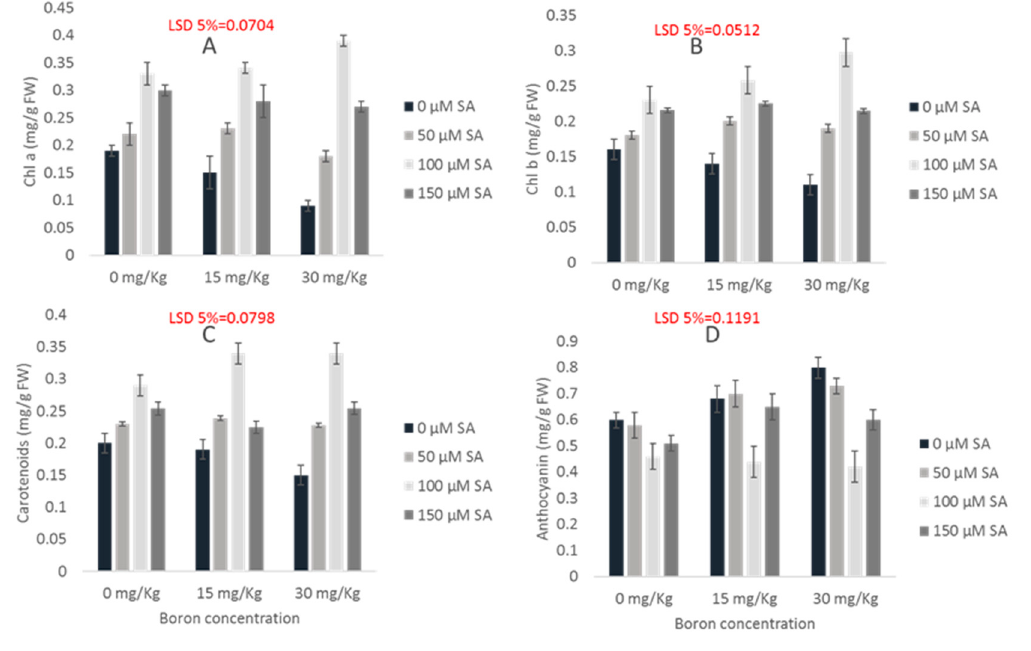
Figure 3. Effect of SA on chlorophyll a ( A ), chlorophyll b ( B ), carotenoids ( C ) and anthocyanin ( D ) contents of maize cultivar Gohar-19 under varying B toxicity levels .